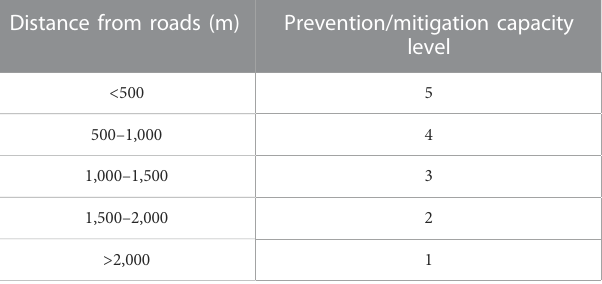
TABLE 6 Classi fi cations of distance from roads. Distance from roads (m)